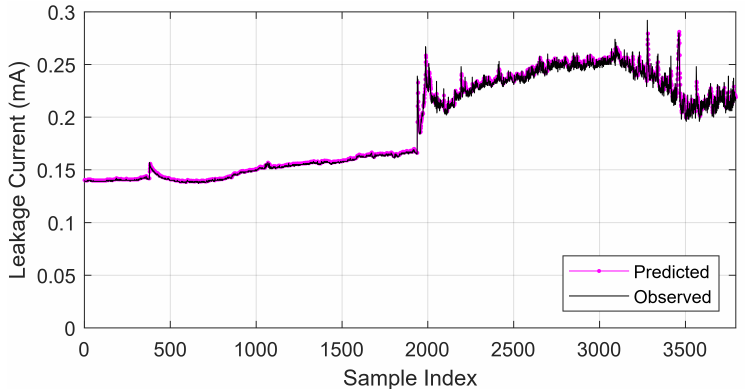
Figure 5. Predicted signal compared to observed